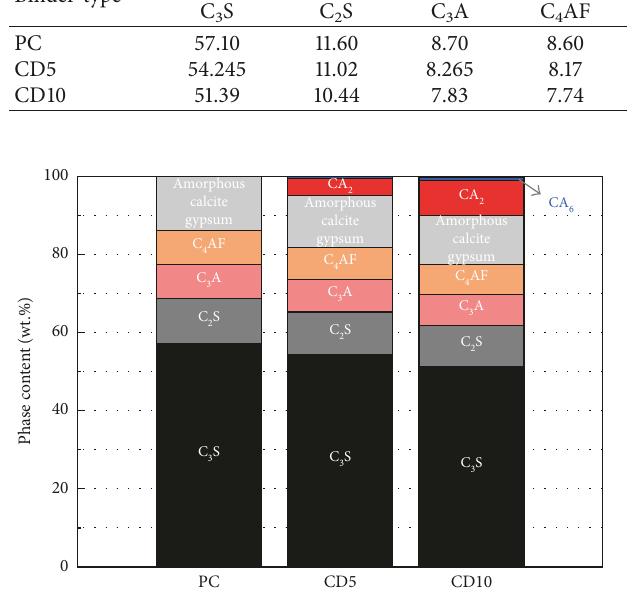
Figure 6: Phase composition of anhydrous PC, CD5, and CD10.